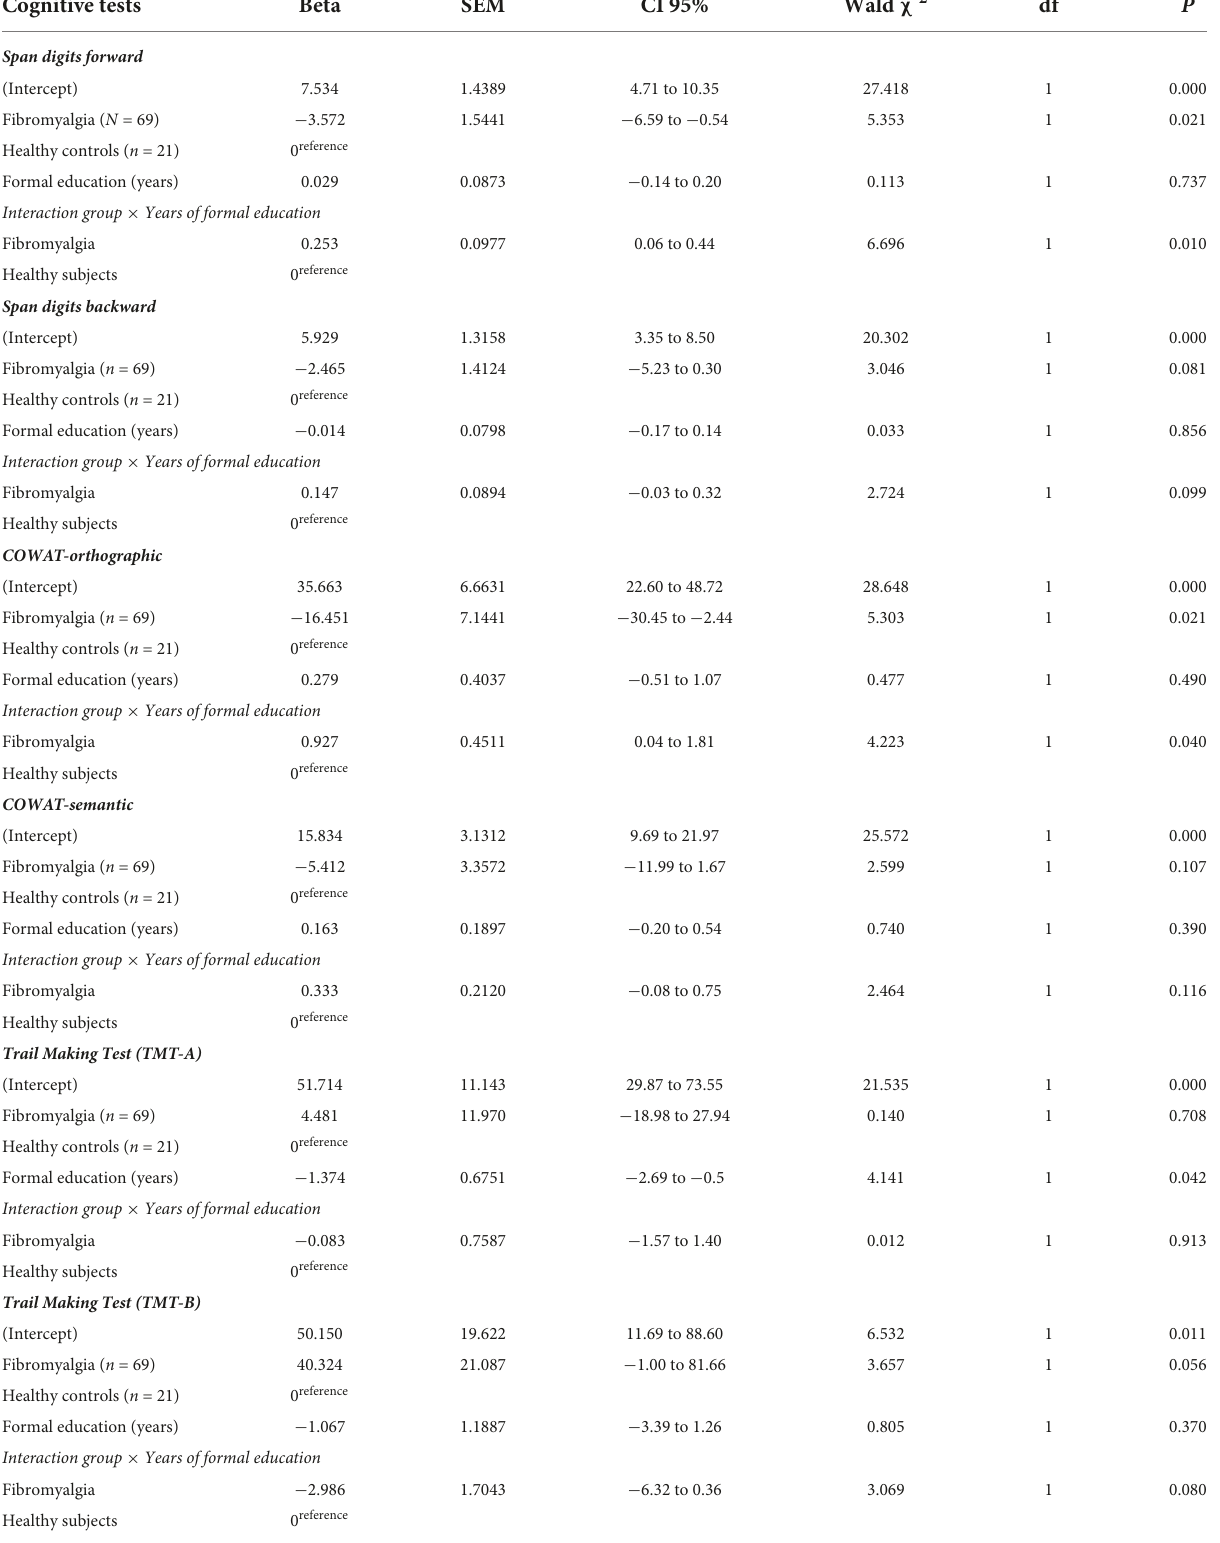
TABLE 2 Primary outcomes–generalized linear model analyses to compare cognitive performance in FM and HC ( n = 90). Cognitive